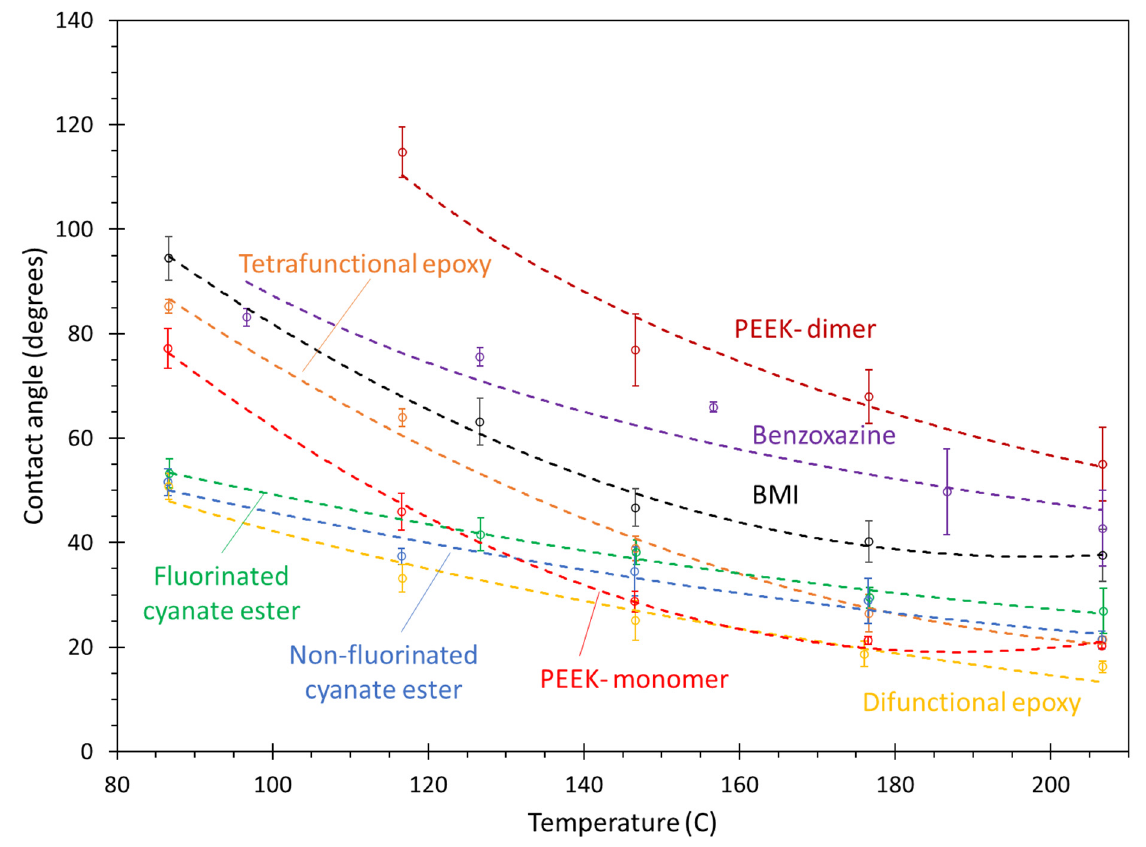
Figure 23. Plot of contact angle vs. temperature of monomers on the aliphatic surface. The lines are curve fits to the data, and the error bars represent the standard error of replicate predictions.